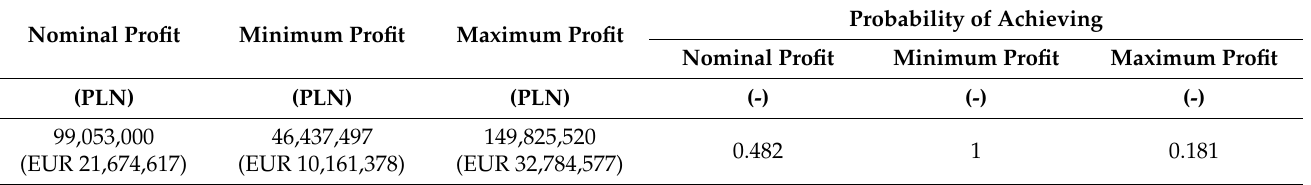
Table 11. A summary of the expected gross profit with the probability of achieving them at σ yprog for mine “F”.